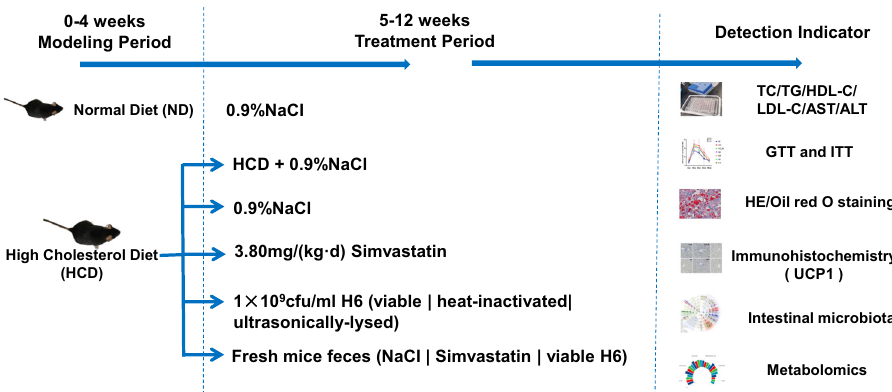
Fig. 8 The fl owchart of the experiment. In the fi rst 4 weeks, 88 male C57BL/6 mice were randomly divided into a normal diet group (ND) and high cholesterol diet group (HCD). From the 5th week to the 12th week, all groups were fed the normal diet except HCD, meanwhile, v/i/uH6 cells (1 × 10 9 cfu/mL) and Simvastatin (3.80 mg/kg BW) were gavaged daily. Group ND and HCD were gavaged with 0.9% NaCl in equal amount every day. The hypercholesterolemia model mice were used as recipients of the FMT test. The FMT was carried out using feces from mice treated with NaCl, and vH6, respectively. (Figure was originated by author. No third party materials were